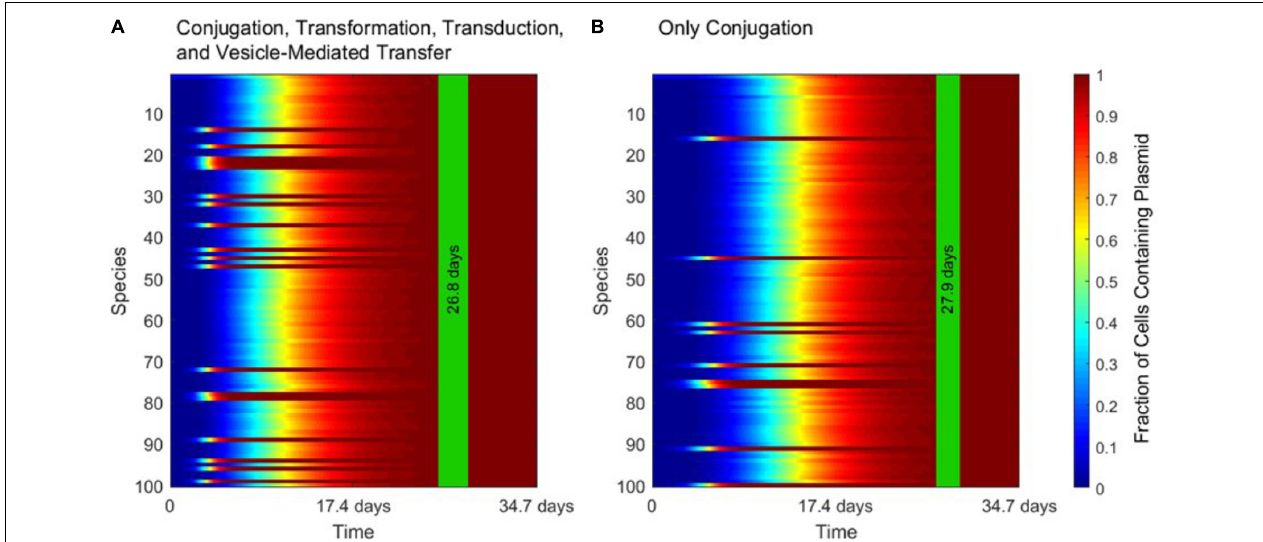
FIGURE 3 | The strong influence of conjugation on horizontal gene transfer. In each panel, the vertical green stripe marks the mean time that the plasmid achieved full spread, plus and minus one standard deviation, for 5 repetitions of the simulation. Each plot shows uptake results for a single run. Full spread is defined as at least 99% plasmid uptake in every bacterial species. (A) In a simulation including all four gene transfer mechanisms, full spread occurred after 26.8 ± 1.4 days. (B) In a simulation with conjugation as the sole transfer mechanism, full spread occurred after 27.9 ± 1.1 days. The p -value of the time to full spread between the two experiments is 0.207 (two-tailed, unpaired t -test), which implies that in the presence of conjugation, the contribution of the other three mechanisms is not statistically